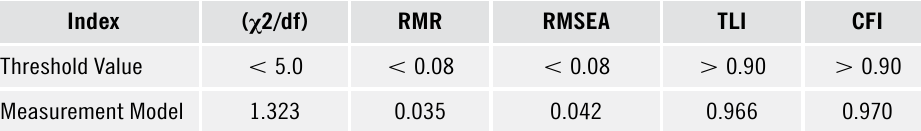
Table 1. Measurement model fit indices